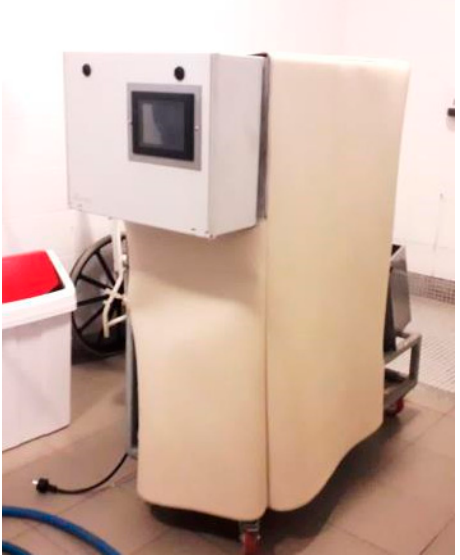
Figure 5. Prototype in test environment.